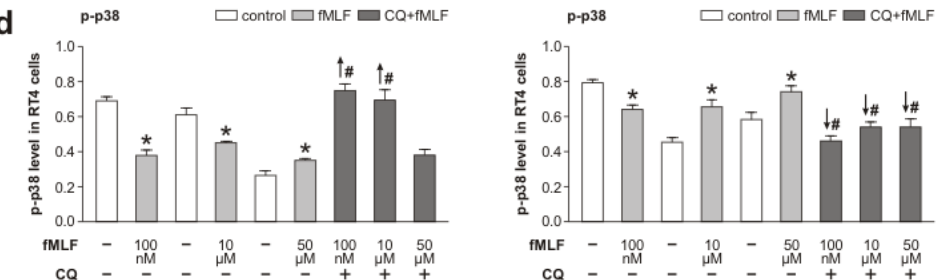
Figure 2. Western blot analysis of activated NF κ B and p38 in RT4 cells after their stimulation with N -formyl-methionyl-leucyl-phenylalanine (fMLF). Changes in NF κ B, p-NF κ B, and p-p38 protein levels in RT4-D6P2T cells following fMLF stimulation at 100 nM, 10 µ M, and 50 µ M for 1 and 6 h and pretreatment with CQ (1 µ M) are shown. Representative Western blots of NF κ B, p-NF κ B, and p-p38 as well as housekeeping protein β -actin of three independent experiments are seen in panel ( a ). The graphs illustrate values expressed as means ± SEM of densitometric measurements for NF κ B ( b ), p-NF κ B ( c ) and p-p38 ( d ) bands after 1 h and 6 h fMLF stimulation and pretreatment with CQ (1 µ M) from triplicate Western blot analyses of RT4 cells. * p < 0.05 compared to control, # p < 0.05 compared to stimulation with the relevant fMLF concentration without 1 µ M CQ, the up and down arrows indicate increased and decreased levels,